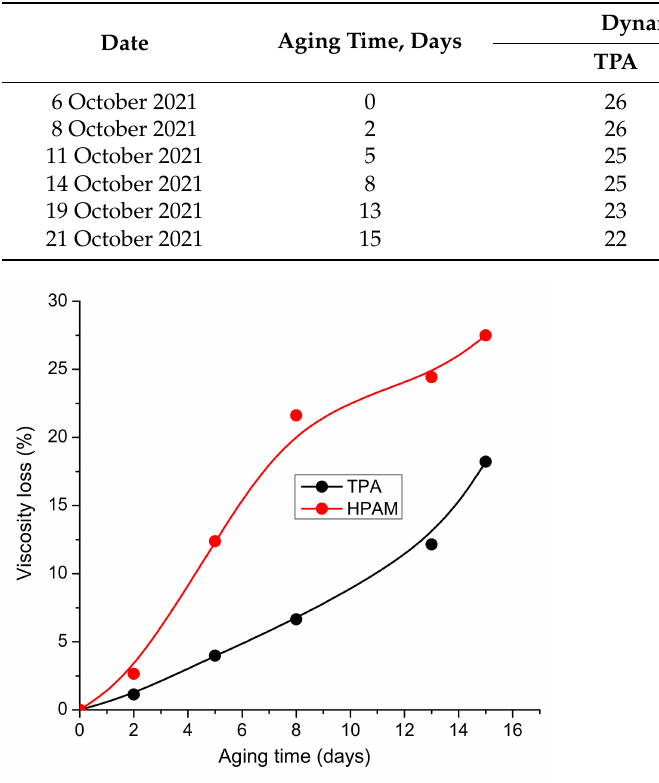
Figure 7. Viscosity loss for 0.25 wt.% TPA and HPAM solutions in 200 g · L − 1 synthetic brine while aging at 24 ◦